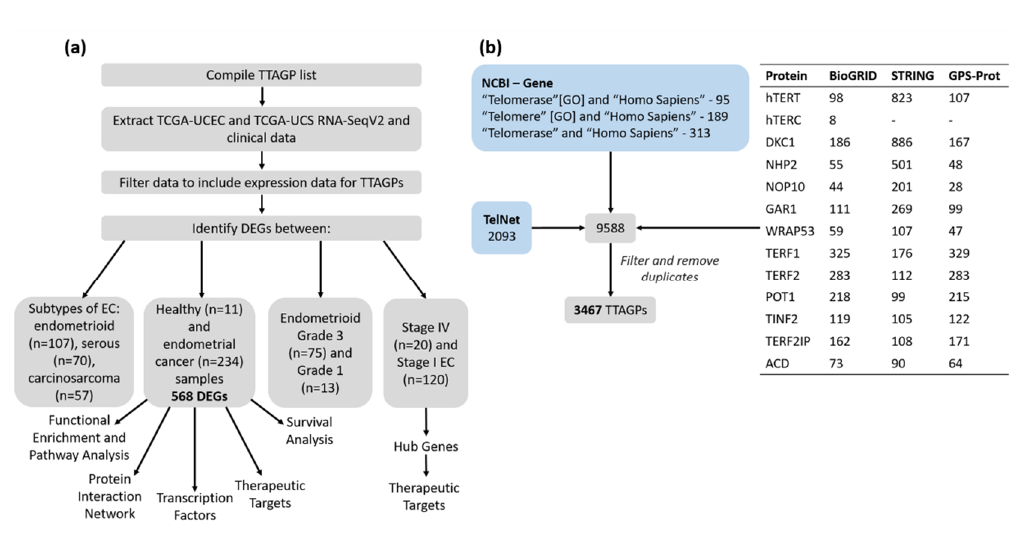
Figure 2. ( a ) Workflow diagram illustrating the in silico procedures. ( b ) Database searches for compiling the list of TTAGPs. The table displays the number of interactors identified for each protein within the telomerase and shelterin complex. WRAP53 and TERF2IP are the official gene symbols for TCAB1 and RAP1, respectively. TPP1 is encoded by the ACD gene.